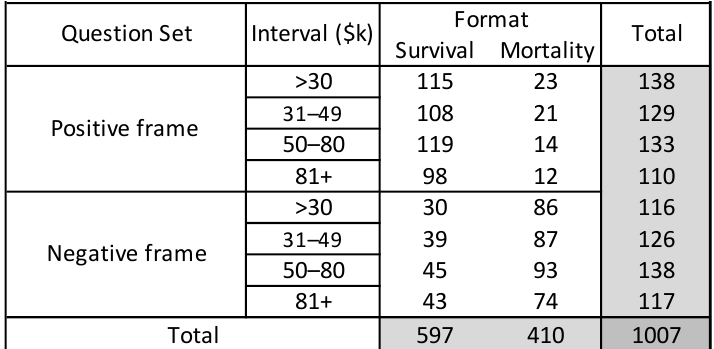
Figure 3. Respondent total by income. Figure 6. Respondent total by